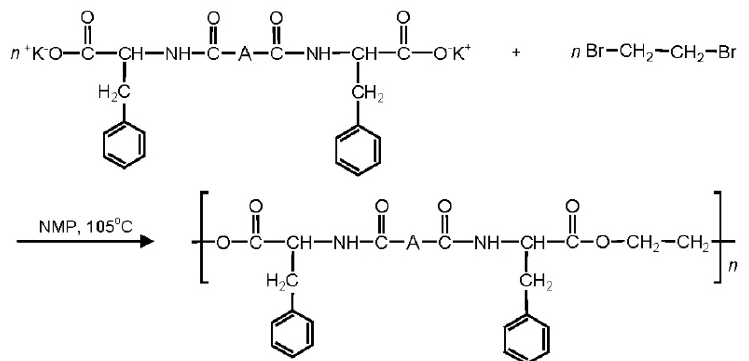
Figure 39. Synthesis of AABBP via nucleophilic substitution (NS) polycondensation.